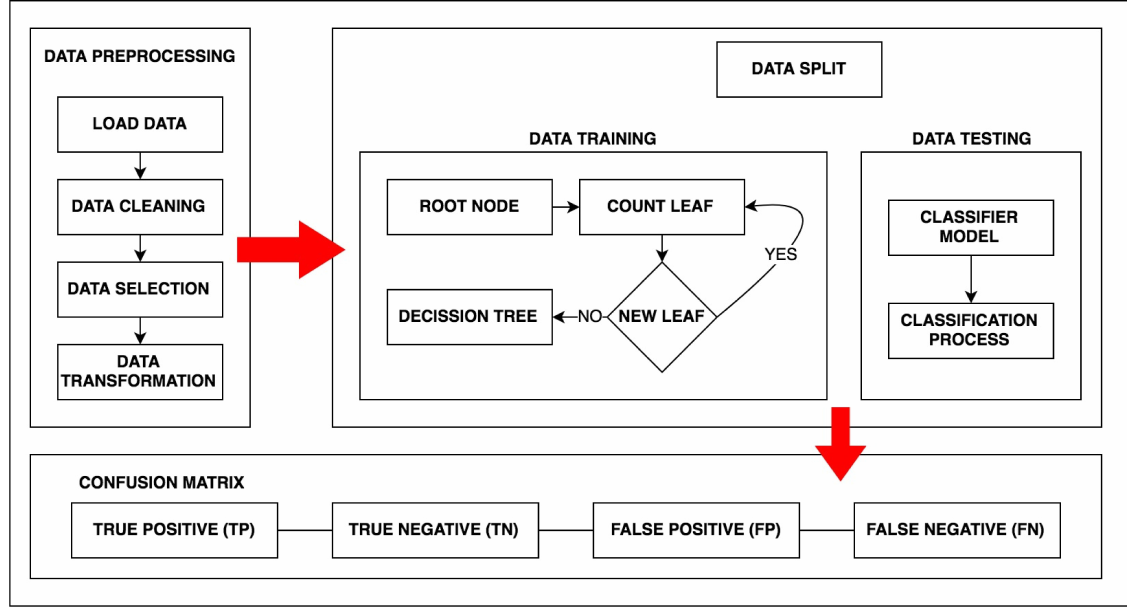
Fig. 1 Prediction for on-time Graduation